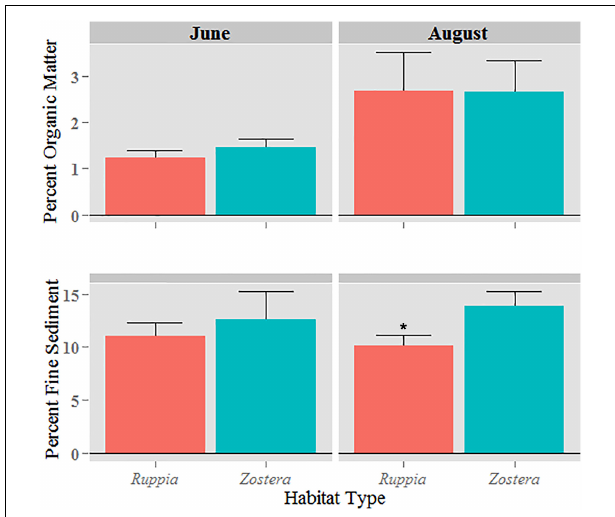
FIGURE 1 | Mean fine content of sediment and organic matter ± standard error at each habitat during the sampling periods. Asterisk indicates mean values are significantly